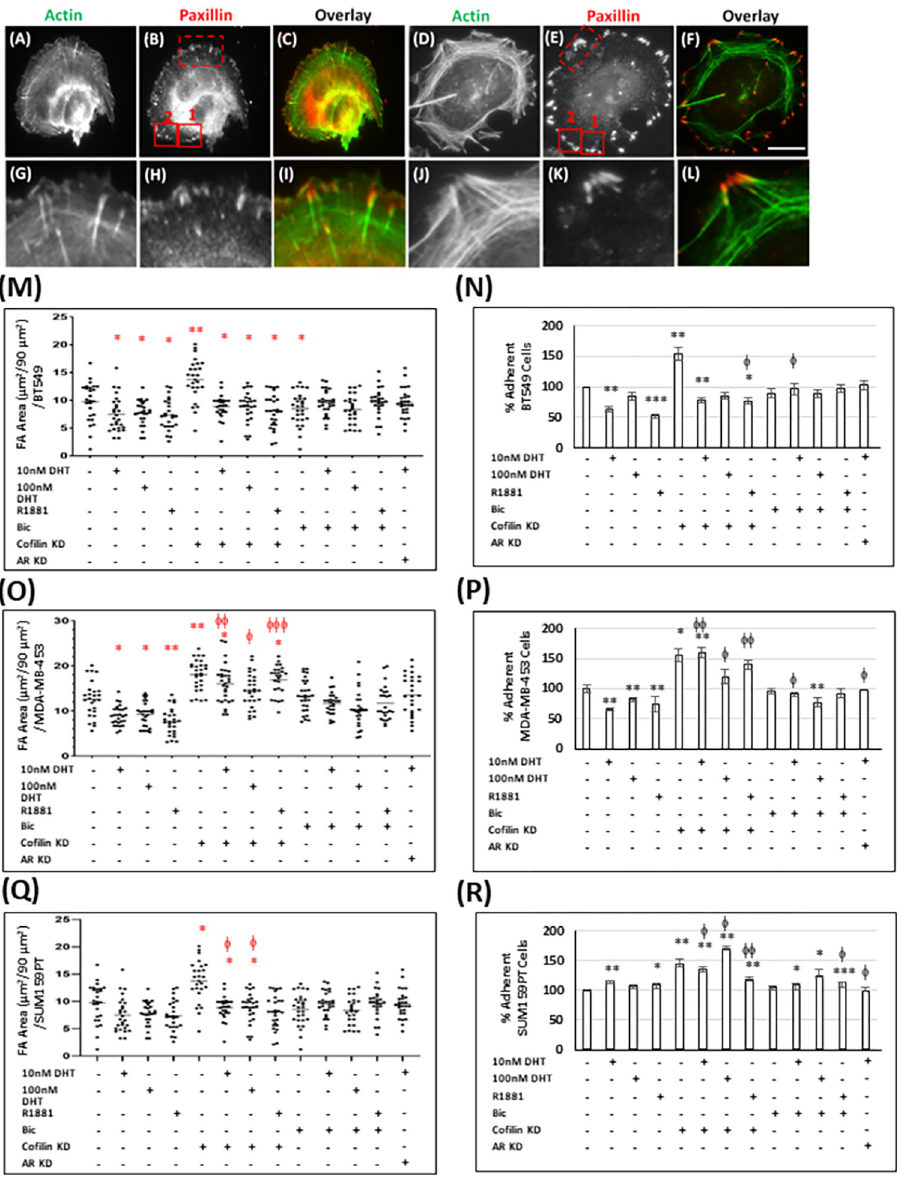
Fig 7. Cofilin suppression enhances TNBC cell adhesion, while androgen treatment of BT549 and MDA-MB-453 cells decreases it. (A-C) Representative images of regular focal adhesion in TNBC cells. (D-F) Representative images of enhanced focal adhesion in TNBC cells. TNBC cells were stained for actin with fluorescent-conjugated phalloidin (A, D), and for focal adhesion with mouse anti-paxillin primary antibody (B, E) (red dashed box, enlarged in G-L). The size and number of focal adhesions per unit area (90 μ m 2 ; red solid boxes in B and E) were measured in Metamorph. Scale bar: 10 μ m. (M, O, Q) Dot plots showing the quantification of total area occupied by focal adhesion ( μ m 2 )/ 90 μ m 2 in BT594 (M); MDA-MB-453 (O), SUM159PT (Q), n � 25 cells. Collagen I adhesion assay was performed for BT549 (N), MDA-MB-453 (P), SUM159PT (R). Average values of cells adherent to plastic (not shown) were subtracted from average values adherent to collagen I. Average values of control cells were reported to 100%. Three independent experiments each performed in triplicate. � p < 0.05, �� p < 0.01, ��� p < 0.001 versus control, ϕ p < 0.05, ϕϕ p < 0.01, ϕϕϕ p < 0.001 versus androgen-treated